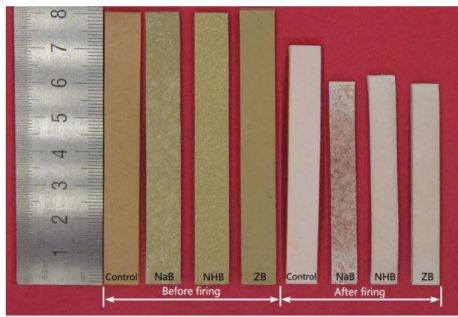
Figure 6. Surface morphology of ceramizable MVQ/HNT composites and corresponding ceramic residues obtained from the pyrolysis products of the composites with the addition of different borates.